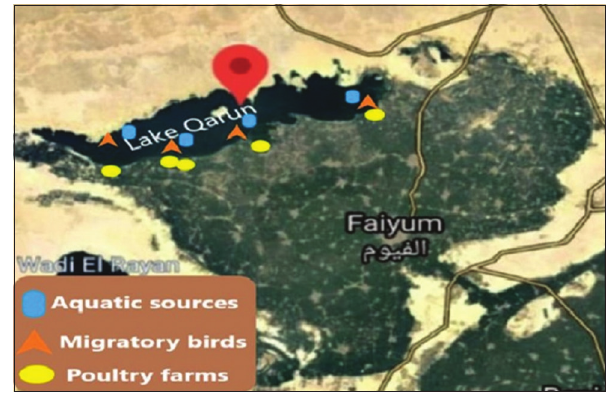
Figure-1: Sampling points and site selection of aquatic, migratory aquatic birds, and poultry samples. [Source: Google